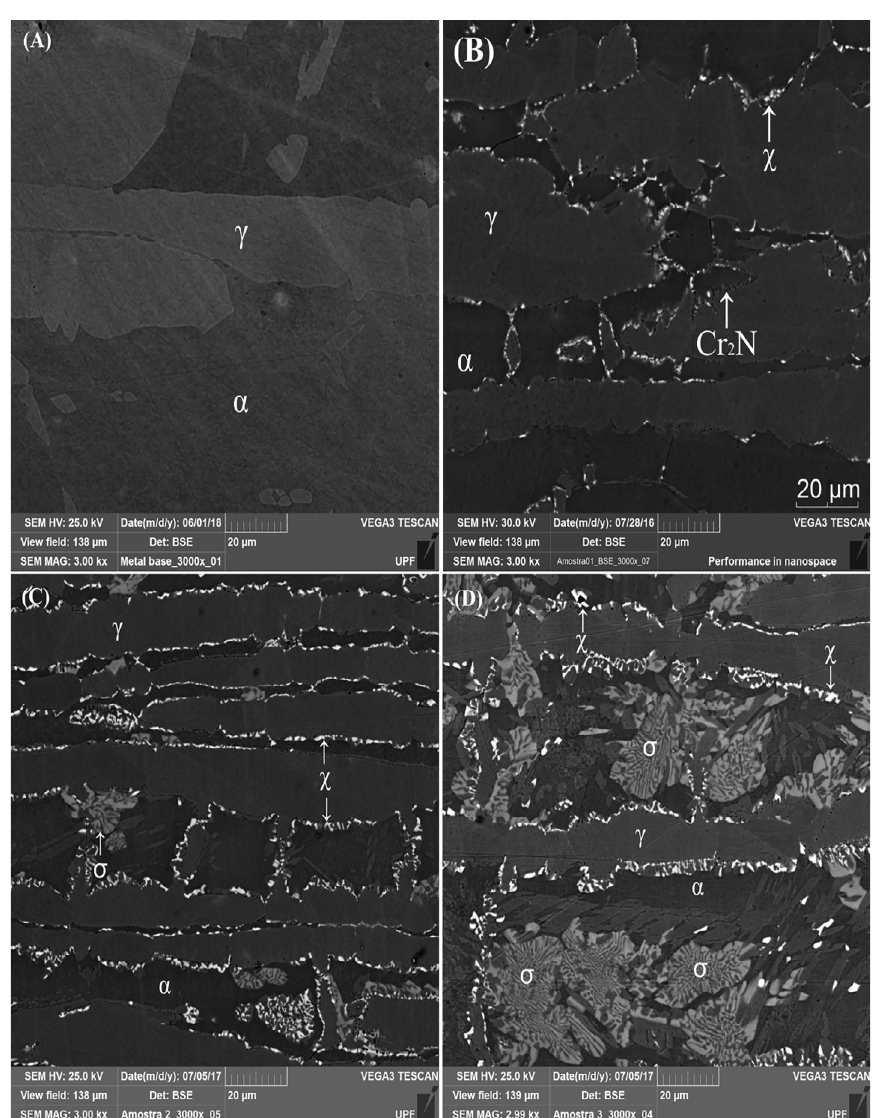
Figure 2. SEM micrographs in BSE mode: (A) As-received material, (B) Ageing at 830C for 30 minutes, (C) Ageing at 830C for 90 minutes, and (D) Ageing at 830C for 180